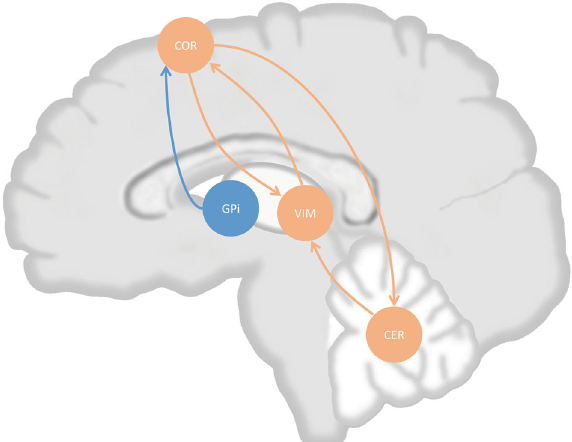
Fig. 1 Dimmer switch model of tremor in Parkinson ’ s disease (PD). Tremor-related activity originates at internal pallidal globus (GPi), which propagate to cortex. Cortex and ventral intermediate nucleus of thalamus (VIM) form a circuit, which is possible the base of tremor-related oscillation. Cerebellum also projects to VIM, this projection possibly modulate amplitude of tremor, while cerebellum was modulated by cerebral cortex. COR cortex, CER cerebellum. Orange arrows indicate projections within cerebello-thalamo- cortical circuit, blue arrow indicates projection from GPi to